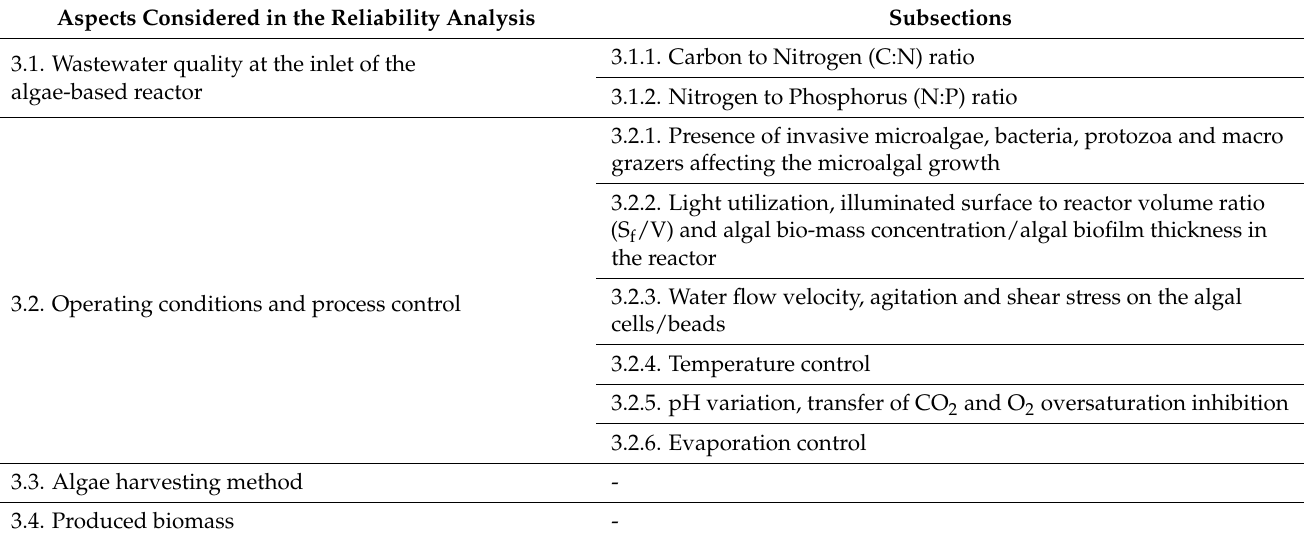
Table 1. Navigation table for Section